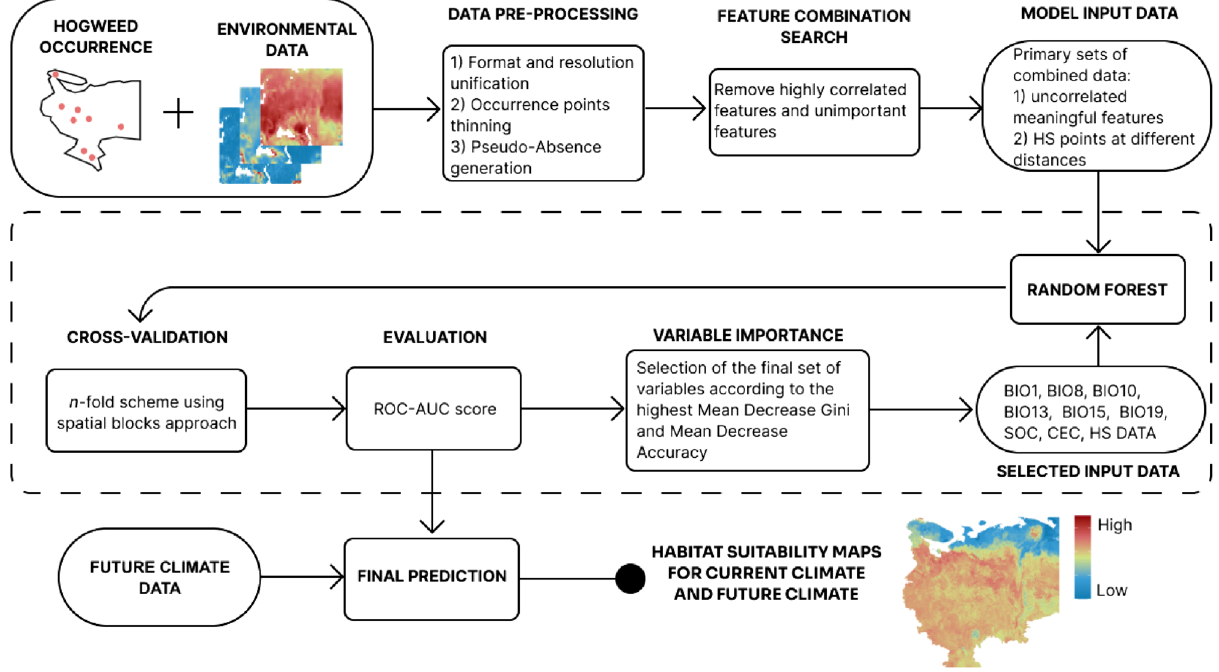
Figure 1. Flowchart of the